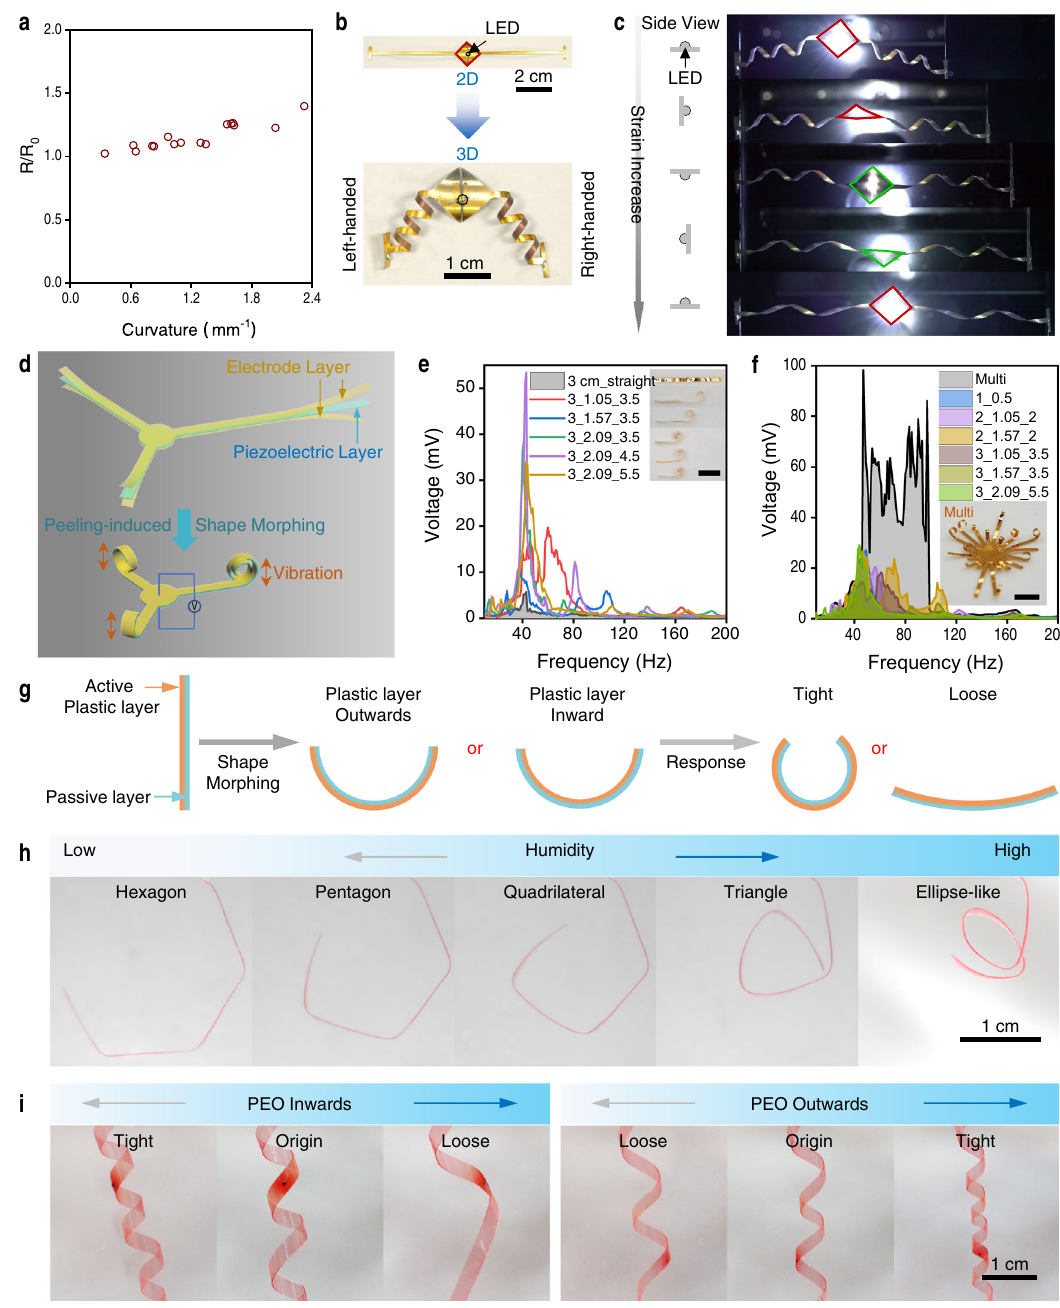
Fig. 5 | Peeling-induced shape morphing for 3D and 4D electronics. a Graph showing that increased bending (measured as curvature) results in only a slight increase in resistance for Au-PTFE fi lms. b A 3D circuit morphed from the 2D one with a light emitting diode (LED) connected to two helical wires with different chirality. c The stretching processes of the circuits in ( b ) with the LED rotating during the stretch but without compromising the light intensity. Left: schematic showing the position changes of the LED. d Schematic illustrations of the 3D cantilever-based piezoelectric systems. The piezoelectric system is of sandwich structurewithtwoelectrodelayersandapiezoelectriclayer.The2Dcantileverscan be transformed into 3D spiral-like structures by peeling-induced shape morphing. e , f The generated voltages of the single cantilever ( e ) and multi-arm cantilever ( f ) piezoelectric systems at different frequencies indicating the peeling-induced 3D